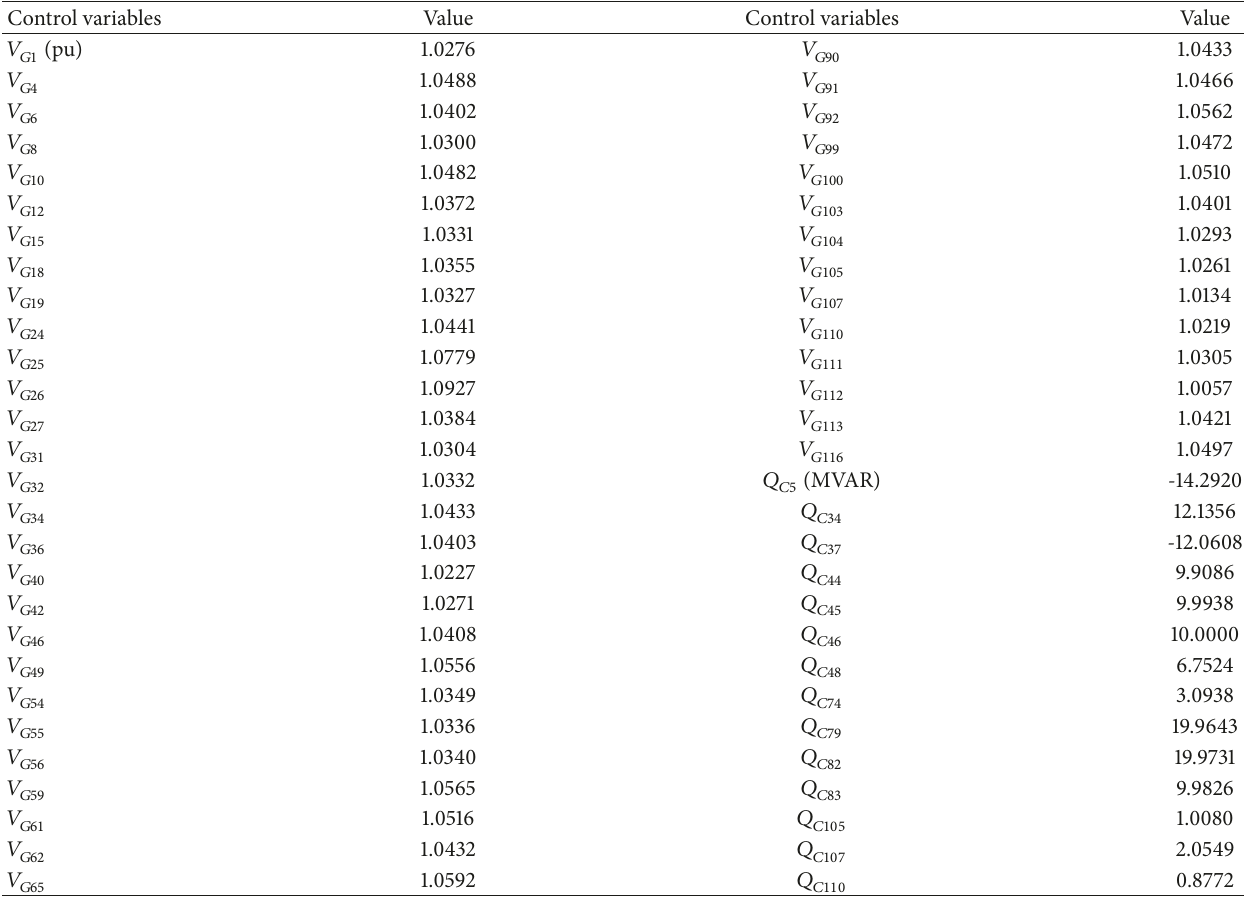
Table 15: Optimal solution obtained by MSFS for the IEEE 118-bus power system with minimization of power